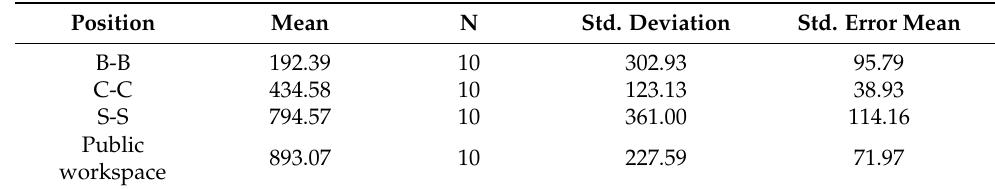
Table 6. Overall descriptive data for time spent under each position with shared interaction (in seconds).